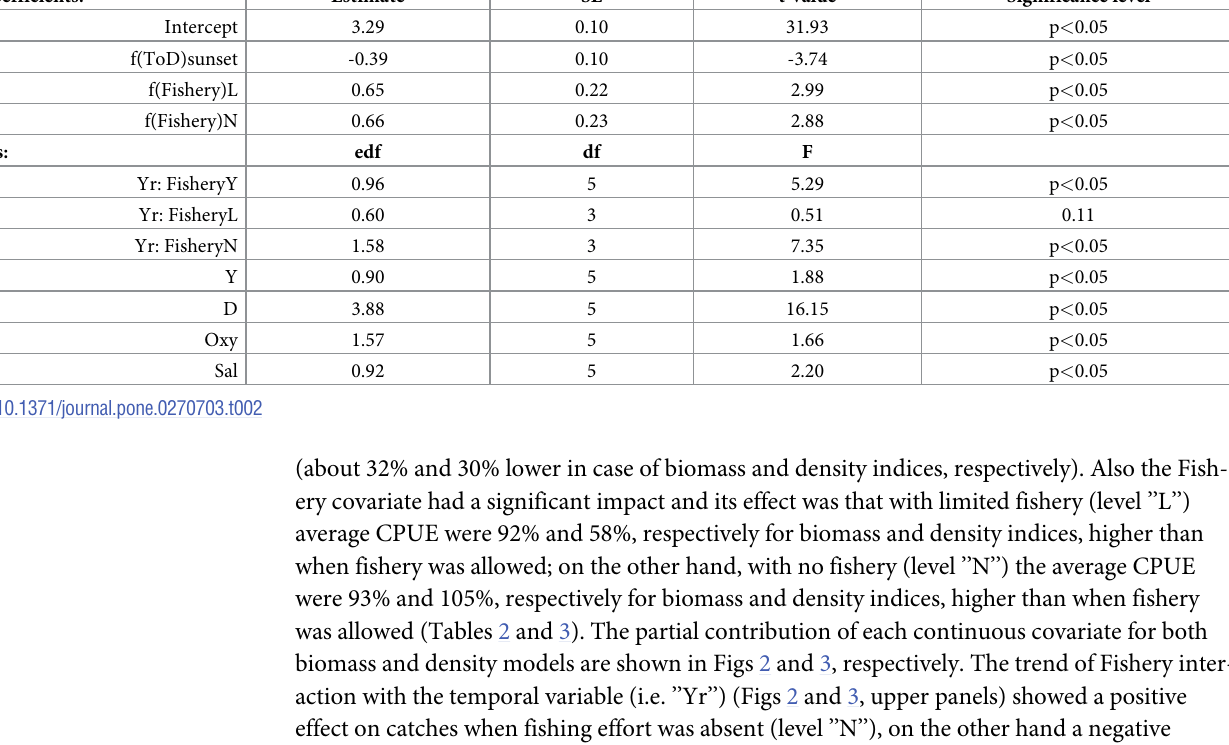
Table 3. Summary of the outputs of the final GAM for the density index (N/km 2 ). Explanatory variables included the single effect of factor Time of the Day (ToD) and Fishery, Year-Fishery interaction (Yr:Fishery) for each level of the factor (“Y” fishery allowed, “L” limited fishery, “N” fishery ban), longitude (Y), depth (D), percentage of dissolved oxygen (Oxy) and salinity (Sal); “SE”, standard error; “edf”, estimated degrees of freedom; “df”, degrees of freedom. Parametric coefficients: